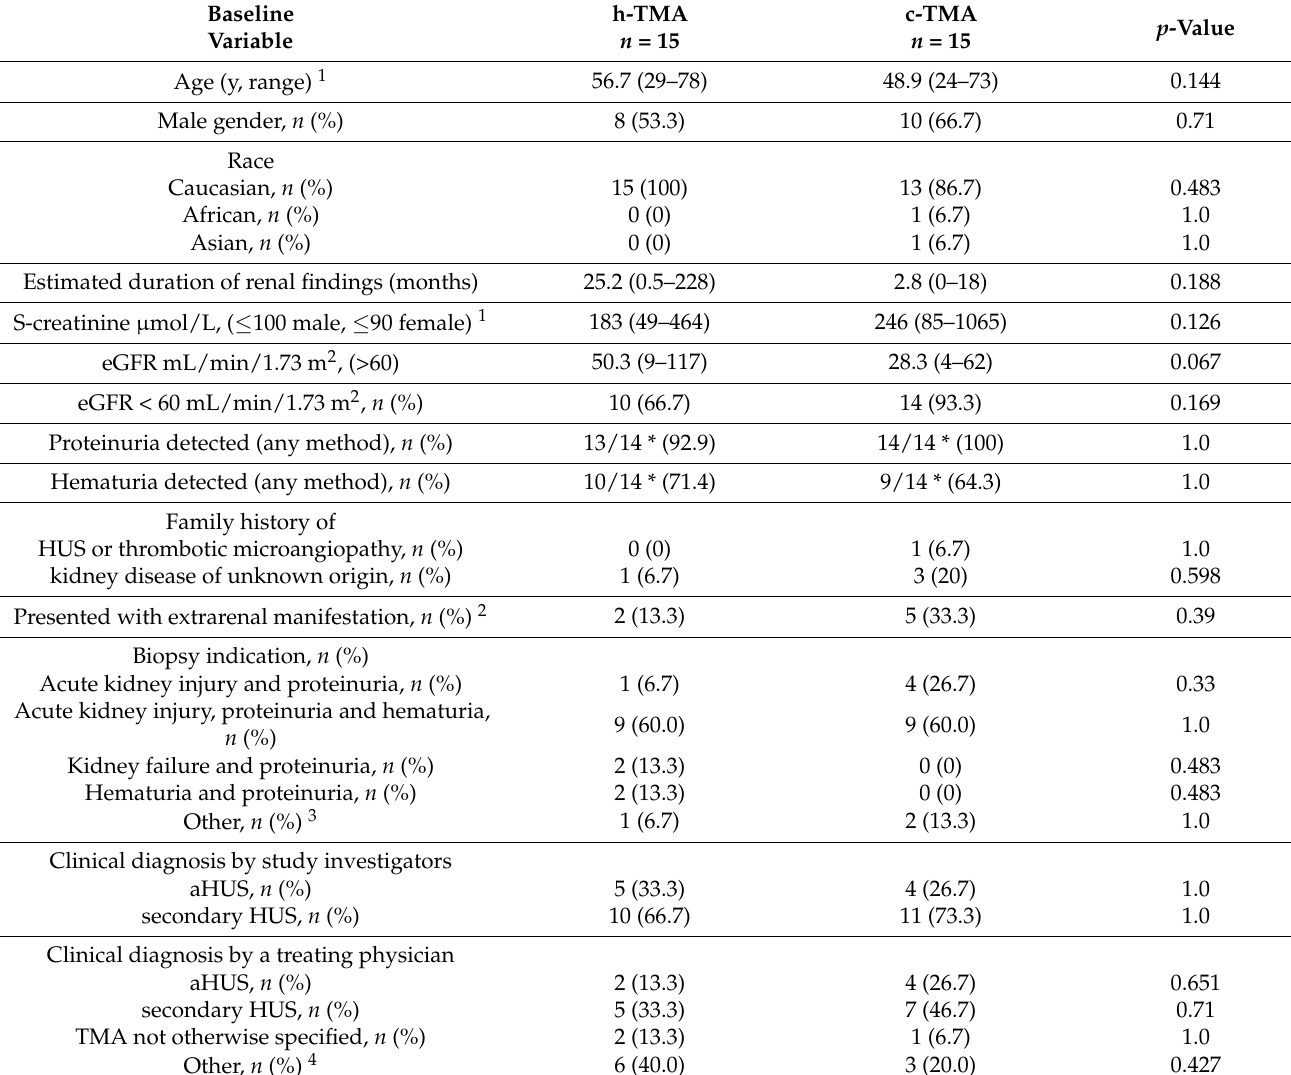
Table 1. Clinical characteristics of the patients recorded at the time of diagnosis. Values are ex- pressed as means (range in parenthesis), or as number of patients (percentages). p -values shows the comparison between h-TMA and c-TMA